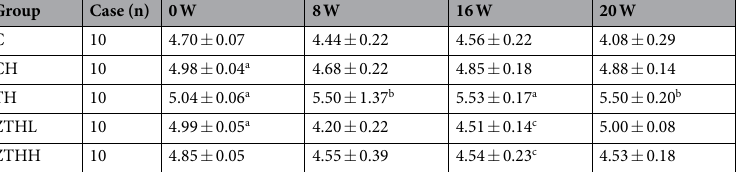
Table 1. Effects of zinc selenium tea on the FBG level in experimental groups (mean and SEM) (mmol/L). a Vs